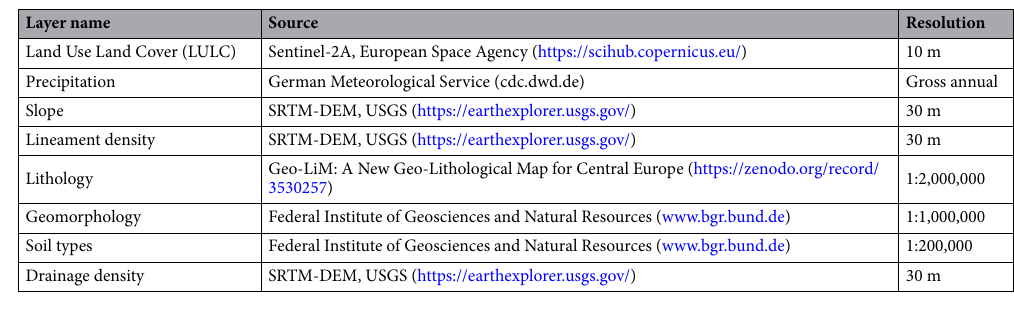
Table 2. Data sources for AHP.